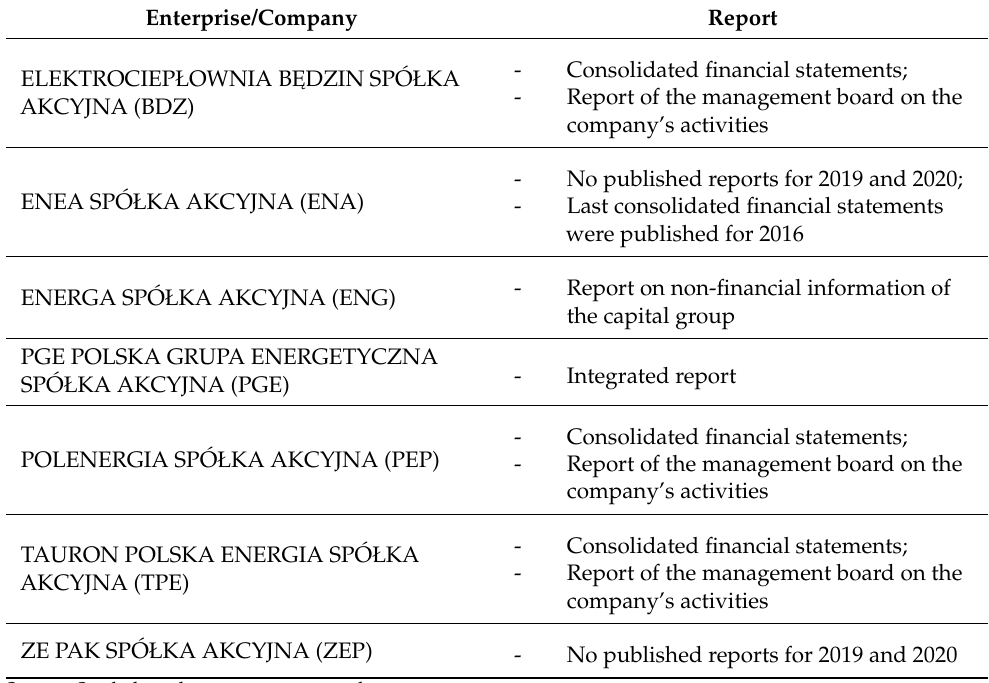
Table 2. List of companies and reports in which financial and non-financial information was